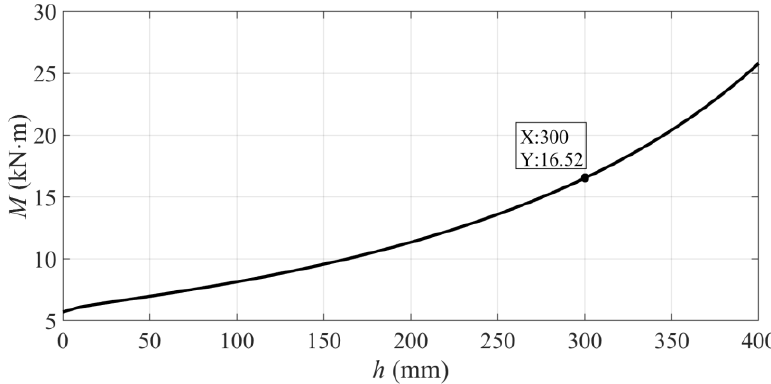
Figure 6. Relationship between the torque on the steering arm and the height of the obstacle.